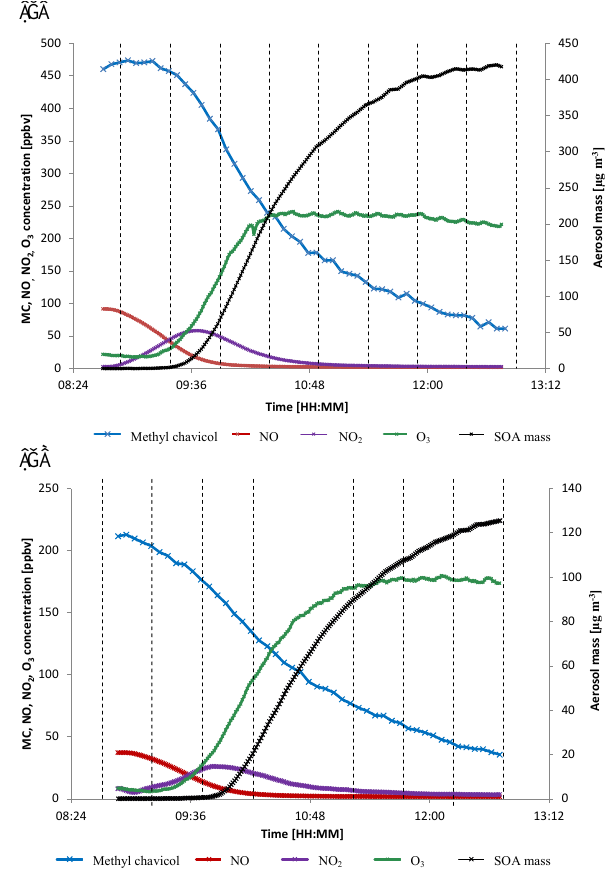
Figure 1. Temporal profiles of methyl chavicol, O 3 , NO, NO 2 and SOA mass for MC low and MC high from the opening to the closing of the chamber housing. (A) MC high (opening chamber housing=08:42UTC, closing of chamber housing 12:45UTC), (B) MC low (opening chamber housing=08:52UTC, closing of chamber housing 12:42UTC). SOA mass is displayed on the sec- ondary y axis and corrected for wall loss and chamber dilution. Dashed lines display the PILS sample start time. The PILS sample start time 10:43UTC in MC low broke during